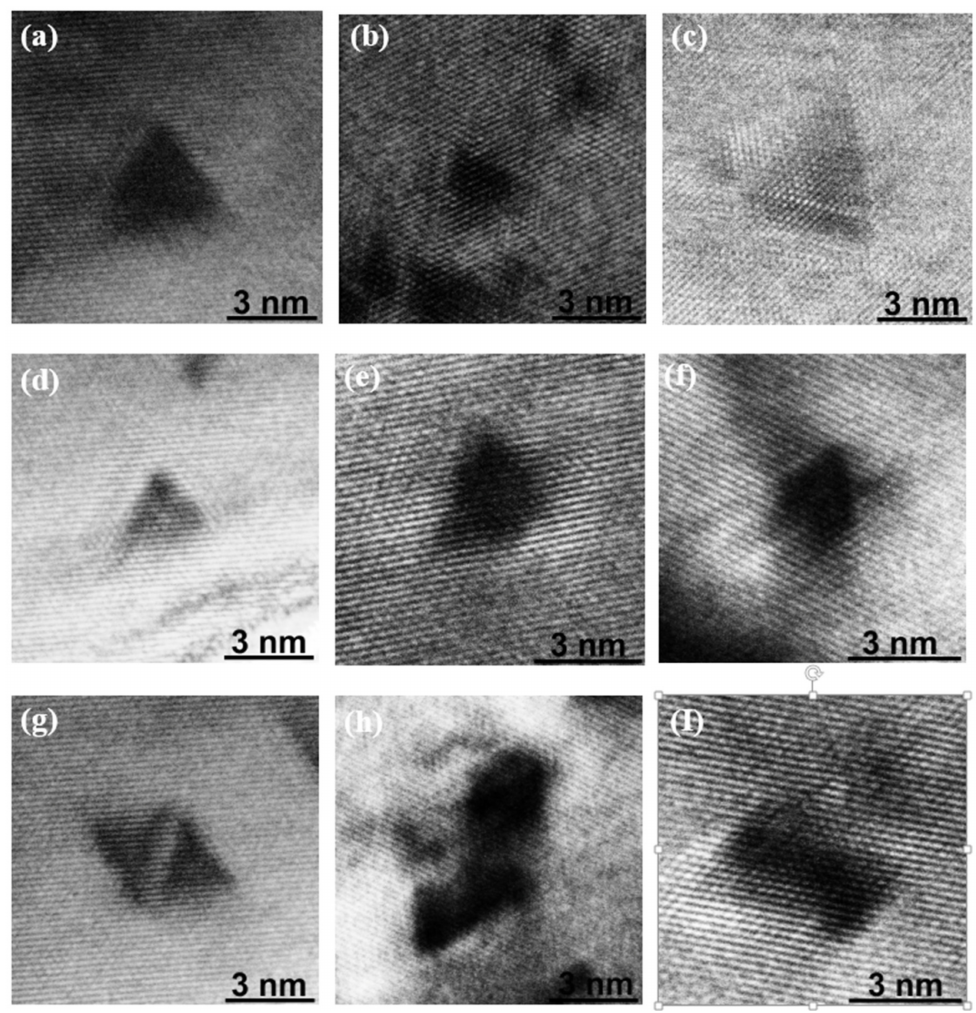
Figure 7. TEM micrographs of SFTs in NWs irradiated by MeV heavy ions. ( a – c ) Perfect SFTs, ( d – f ) truncated SFTs, and ( g – i ) group of intermixed stacking fault tetrahedron (SFT). By counting more than 100 SFTs in gold NWs irradiated by Xe and Kr ions with different energies and choosing the side length of the triangle in the TEM micrograph as the SFT size, the size distribution of SFTs produced by different ion irradiation values is shown in Figure 8a. Here, only the SFTs whose sizes are larger than 2 nm are taken into account. The size distribution of produced SFTs varies under different irradiation conditions. It is concluded that the most probable distribution in size of SFTs is increased from 2.5 nm to 4 nm when increasing the nuclear stopping power of incident ions according to Table 1, and the average size of all the statistic SFTs is positively related to the nuclear stopping power (in Figure 8b). For the higher nuclear stopping power, a heavy ion impact can deposit more energy in the displacement collision cascade, which may result in the larger